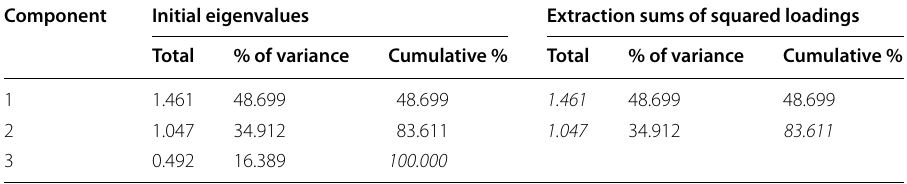
Table 6 Principal component variable loading